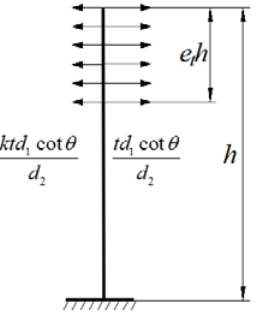
Figure 8. Equivalent force diagram of the tower.